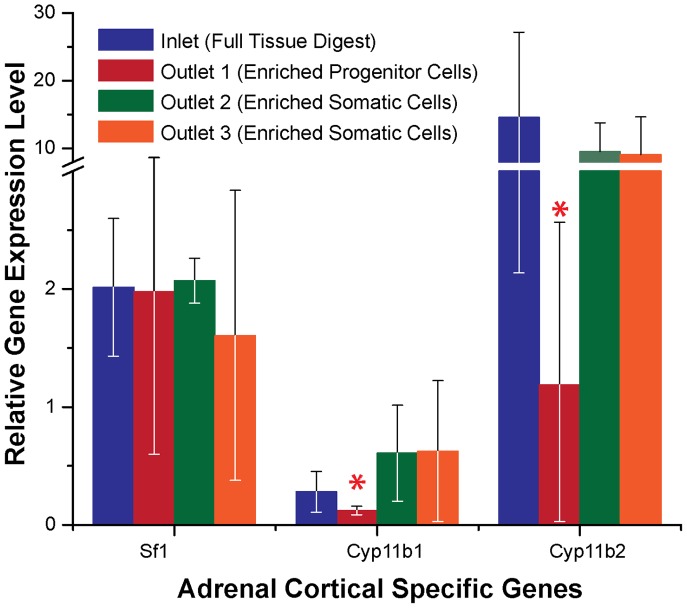
Relative gene expression levels of Sf1, Cyp11b1, and Cyp11b2 of all adrenal cells collected at each fraction of outlets.Each adrenal specific gene expression level was normalized to that of pooled neonatal adrenal glands. The levels of Sf1 were similar (P = 0.9) for all conditions, whereas Cyp11b1 and Cyp11b2 were differentially expressed for fractions collected at different outlets. The expression of zonal-specific genes (Cyp11b1 and Cyp11b2) was significantly lower in the fraction of outlet 1 than that for the rest of samples. Red asterisks indicates P<0.05 compared with NR bright cells from outlet 3. Error bar represents the standard deviation of measurements from two animals.